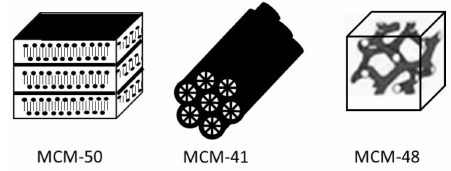
Figure 2. Schematic diagram of the M41S materials, MCM-50 (layered), MCM-41 (hexagonal), and MCM-48 (cubic). MCM stands for Mobil Composition of Matter.